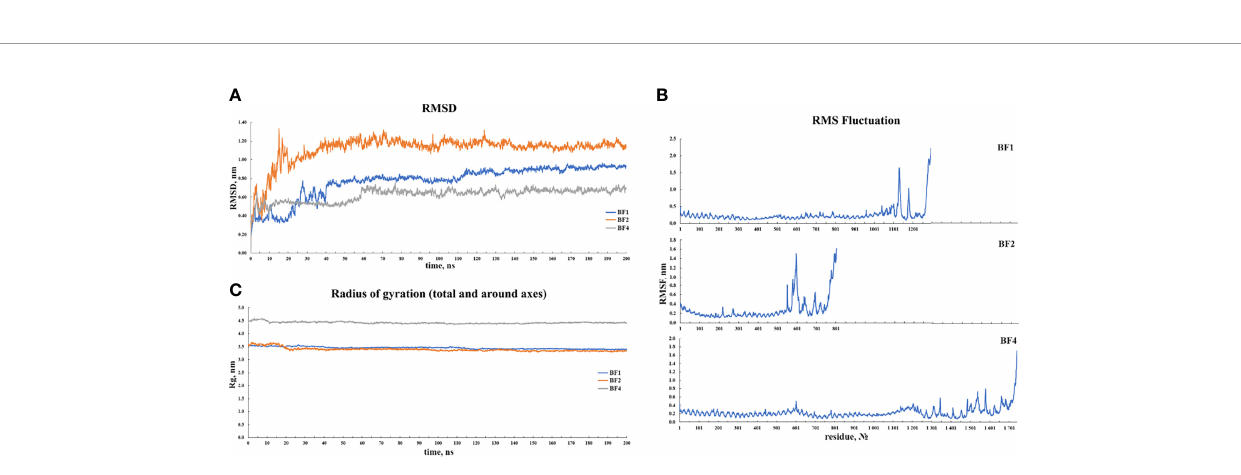
FIGURE 8 | Results of the (A) RMSD, (B) RMSF and, (C) radius of gyration analyses of the three vaccine-TLR docked